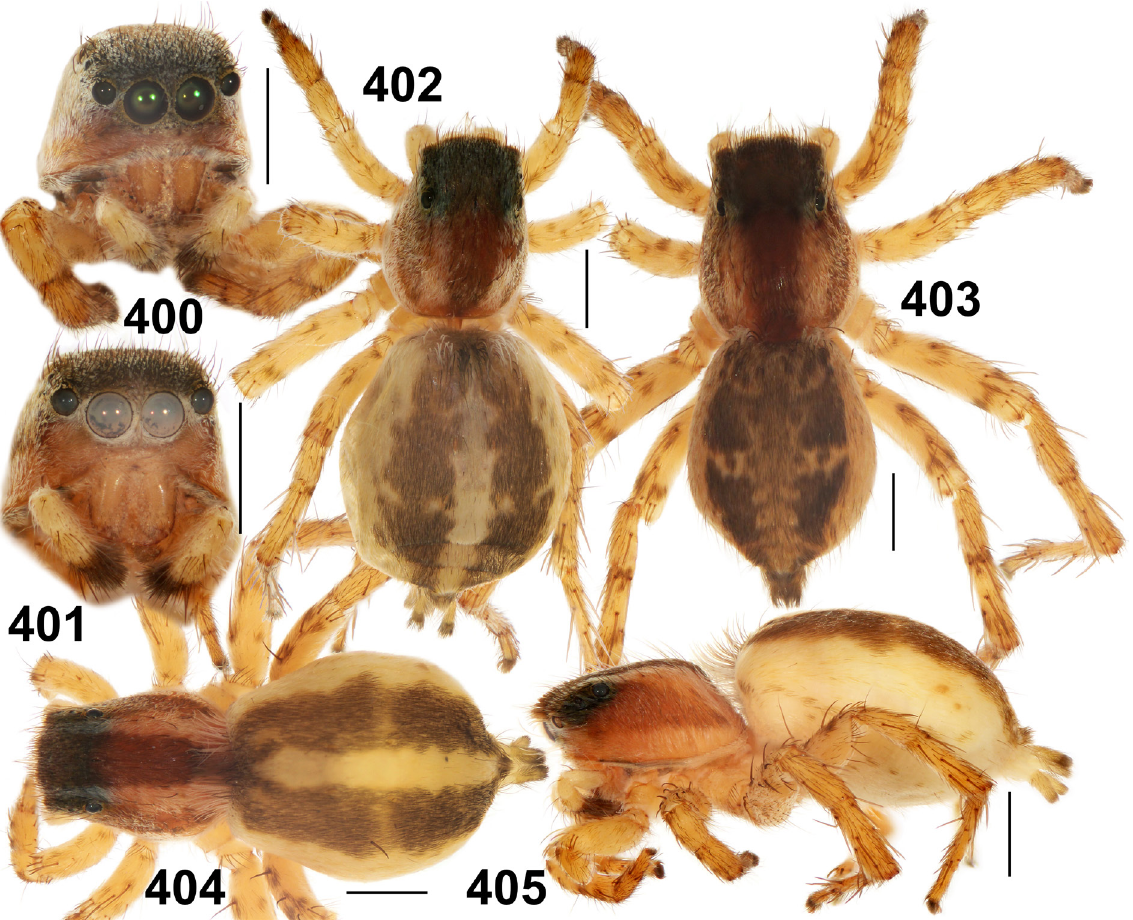
Figs 400–405. Stenaelurillus nigricaudus Simon, 1886 , ♀♀, general appearance . 400 , 402–403 . Senegal (Richard Toll). 401 , 404–405 . Burkina Faso. Scale bars: